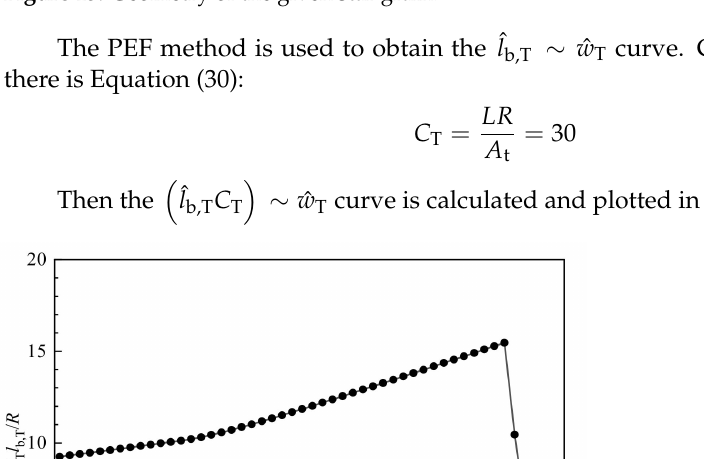
Figure 15. Geometry of the given star grain.